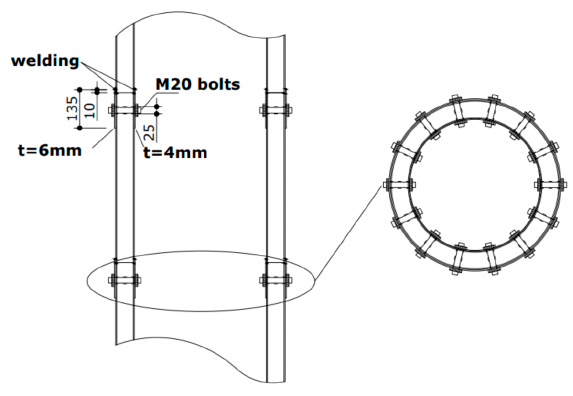
Figure 8. Socket type connector (Type-S).